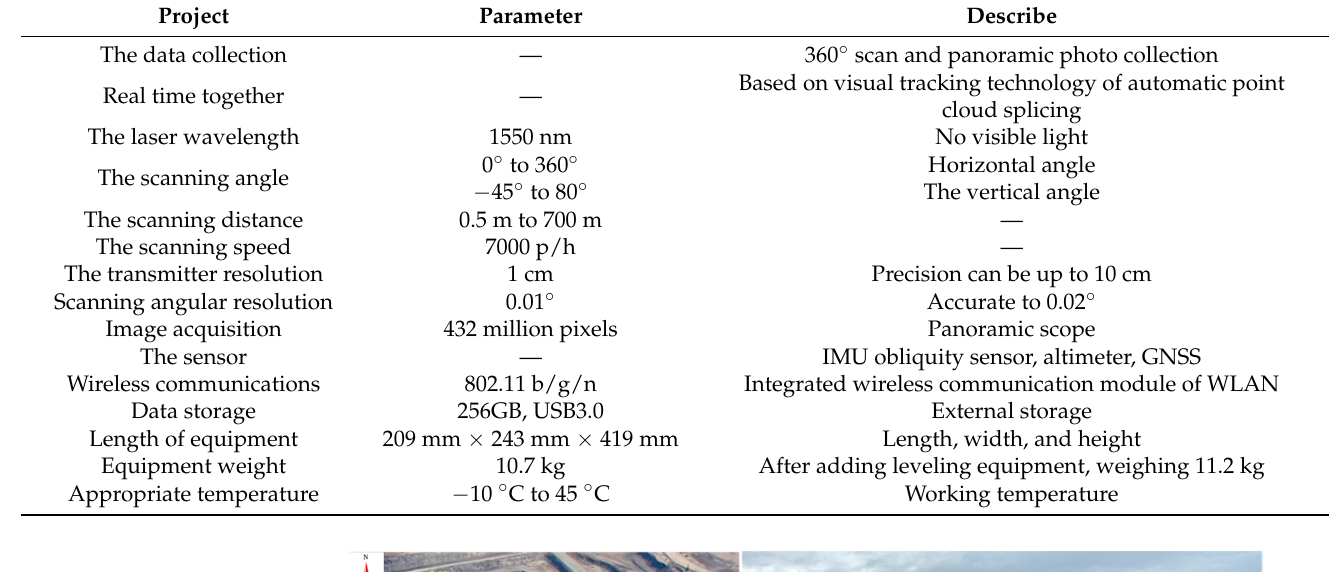
Table 1. Quarryman high-precision scanner equipment parameters.